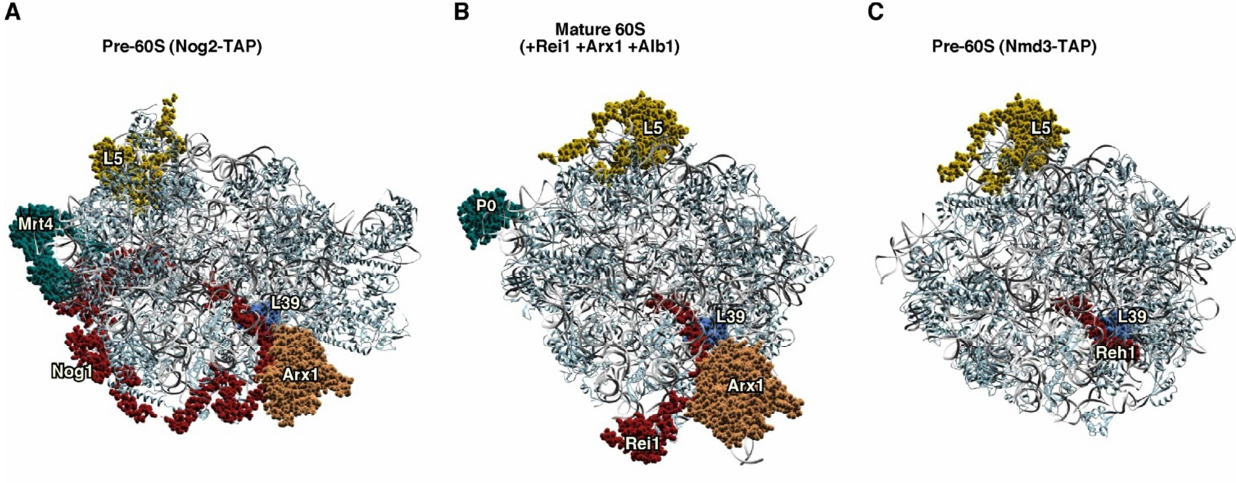
Figure 6: Interactions at the polypeptide exit tunnel of pre-60S ribosomal particles. (A) Position of Nog1 (red) and Arx1 (dark gold) in the early pre-60S r-particle purified with Nog2-TAP (PDB ID: 3JCT; [40]). Note that the C-terminal part of Nog1 enters the tunnel. The location of Mrt4 (cyan) is also shown. (B) Position of Rei1 (red) and Arx1 (dark gold) in a reconstituted 60S r-subunit (PDB ID: 5APN; [68]). Note that only the middle part (141-261) and the C-terminal end (300-393) of the protein is visualised. As above, the C-terminal part of Rei1 enters the tunnel. The location of P0 (cyan) is also shown. (C) Position of Reh1 (red) in the late/cytoplasmic pre-60S r-particles purified with Nmd3-TAP (PDB ID: 5H4P; [43]). Note that only the region of the protein occluding the tunnel could be visualised (amino acids 377-432 of 432). Particles are viewed from the solvent side. For orientation, the locations of L5 (yellow) and L39 (blue) have been highlighted. The rest of rRNAs are coloured in pale blue and the rest of r-proteins and/or factors in light cornflower